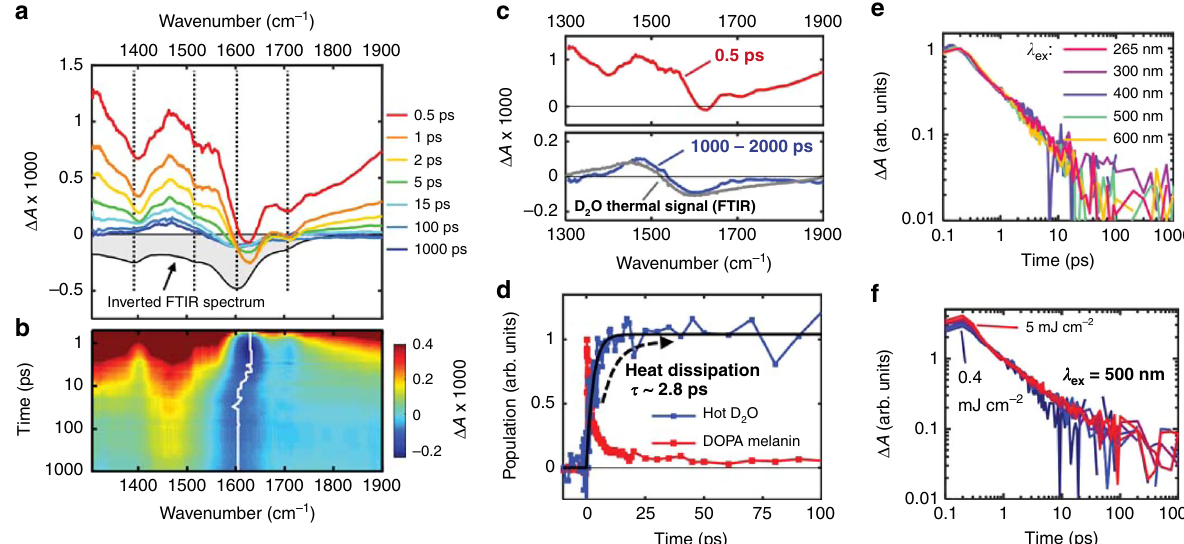
Fig. 5 Time-resolved infrared (TRIR) spectra and kinetics of DOPA melanin. a Transient absorption spectra of a solution of DOPA melanin dissolved in phosphate-buffered D 2 O, shown at several time delays after 265 nm excitation. Vertical dotted lines indicate ground state absorption peak positions. b The corresponding two-dimensional transient absorption map, showing Δ A × 1000 with a colormap from − 0.25 (blue) to 0.4 (red). The white trace shows the kinetics of the minimum signal intensity of the transient absorption spectrum. c Basis spectra selected for spectral modeling. The gray spectrum shows the D 2 O thermal signal estimated using temperature-dependent FTIR spectra (see Supplementary Fig. 4). d Isolated kinetics of the DOPA melanin signal compared with the D 2 O thermal signal. The black trace is a fi t to the latter with an exponential growth model, and the corresponding time constant ( τ ) is shown. e Normalized excitation wavelength-dependent transient absorption kinetics of DOPA melanin probed at 1310 cm − 1 . f Power-dependent kinetics probed at 1310 cm − 1 and recorded using 500 nm excitation, normalized at 1 ps. Seven traces are shown with pump pulse fl uences that vary between 0.4 and 5.0 mJ cm − 2